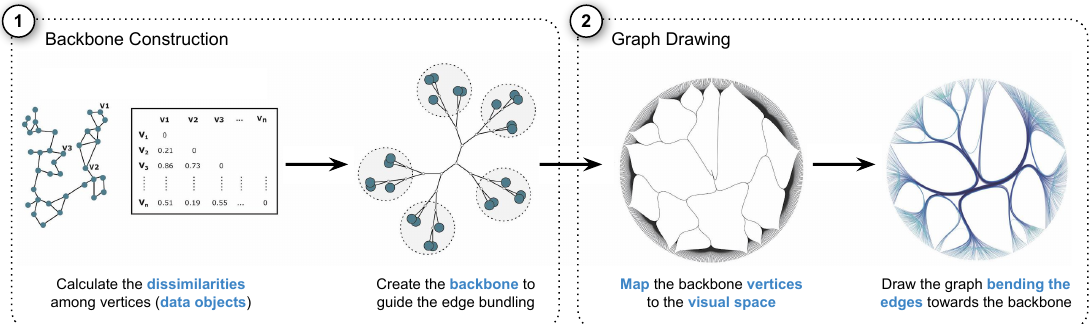
Figure 1. SDEB overview. Using dissimilarities computed between graph vertices (data objects) as input, a backbone to guide the bundling process is created linking the vertices according to their similarity. Next, the backbone is mapped to the visual space using a tree layout strategy, and the graph is drawn bending the edges towards the backbone